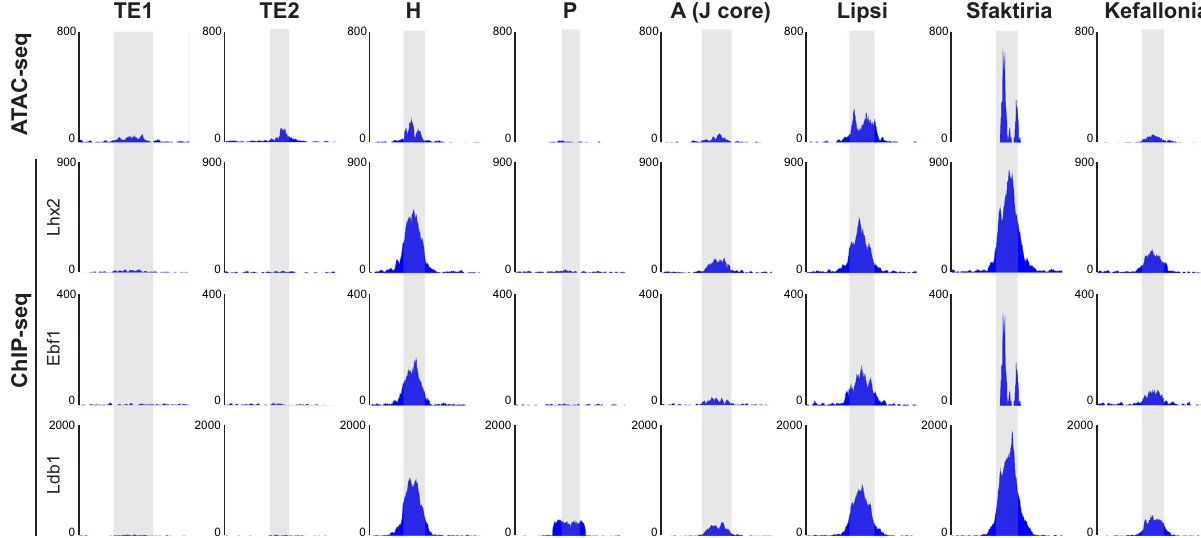
Fig. 4 TE1 and TE2 share some but not all epigenetic features of OR enhancers. ATAC-seq and ChIP-seq data from all mature OSNs 21,27 in genomic regions corresponding to TE1 and TE2, and known functional OR enhancers: H, P, A (J core), Lipsi, Sfaktiria and Kefallonia. T-elements show similar chromatin accessibility, but lack Lhx2, Ebf1 (O/E), and Ldb1 binding that is observed in most of the known functional OR